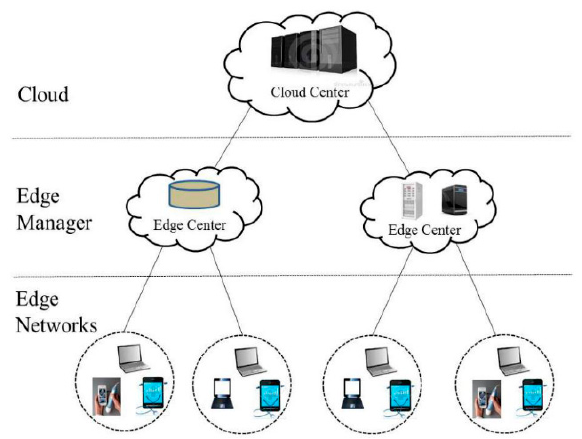
Figure 2. Architecture of edge computing.